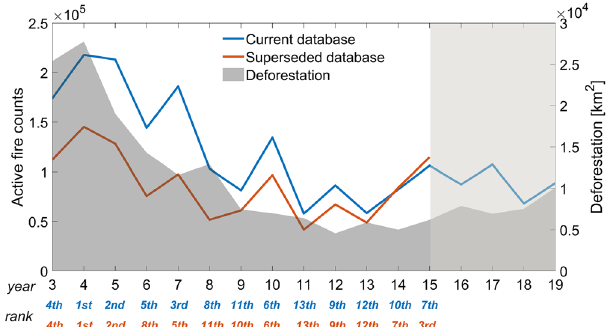
Figure 1. Interannual variability of fire activity and deforestation in the region during 2003–2019. Annual MODIS/AQUA active fire counts, left y-axis, for the current database (blue line) and for superseded database (red line) time series over the BAMZ. Each year is ranked by number of active fire counts (in blue for the current and in red for superseded databases) from 2003 to 2015. PRODES deforestation rates are depicted as the background gray area, right y-axis. Trend significance was analyzed with a two-tailed Mann–Kendall test of significance at the 0.01 level, and trend slopes were estimated using the non-parametric Theil-Sen robust linear